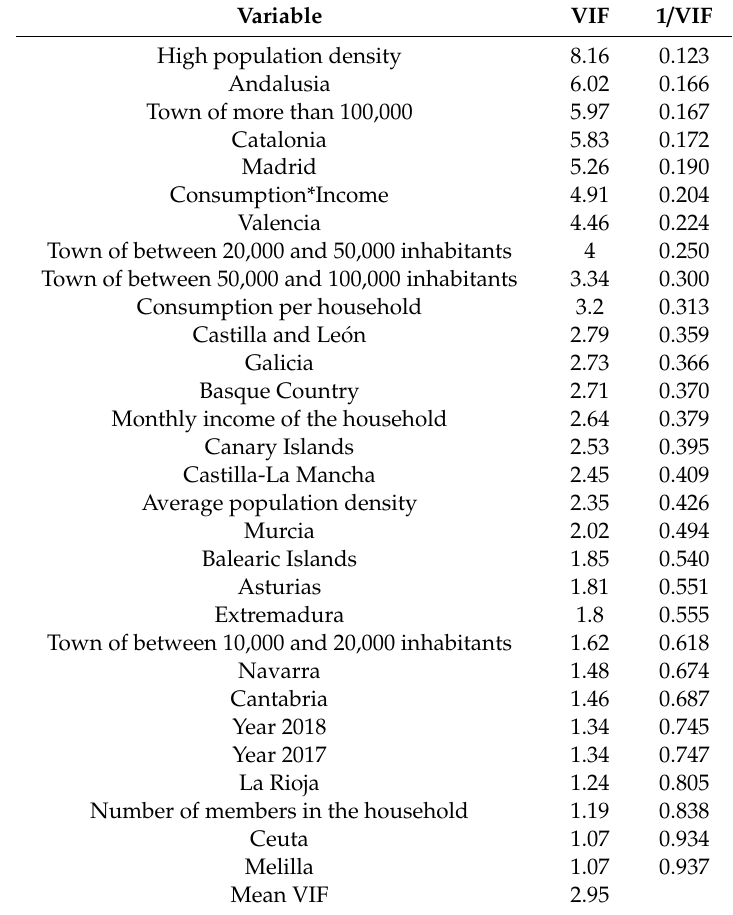
Table A4. Results of the variance inflation factor (VIF) in the price model (with